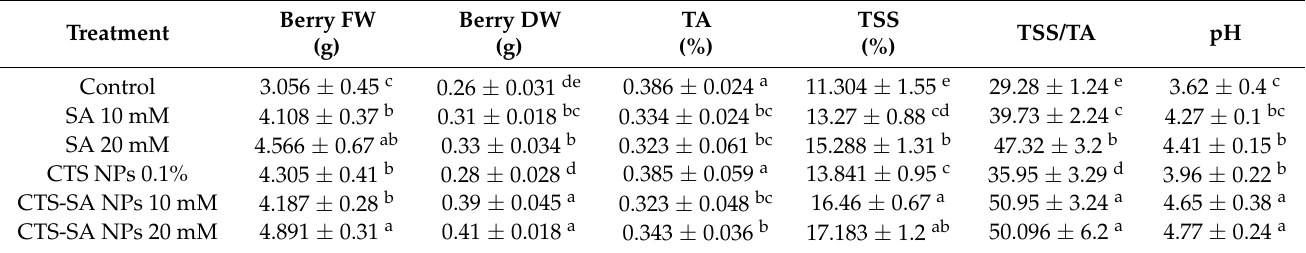
Table 1. The effect of salicylic acid (SA) (10 and 20 mM), chitosan (CTS) (0.1%), and their combination in the nano-form (CTS-SA NPs) treatments on fresh (FW) and dry (DW) weights, titrable acidity (TA), total soluble solids (TSS), TSS/TA ratio, and pH of the grape ( Vitis vinifera L.) cv. Red Sultana. Different letters indicate significantly different values at p ≤ 0.05.